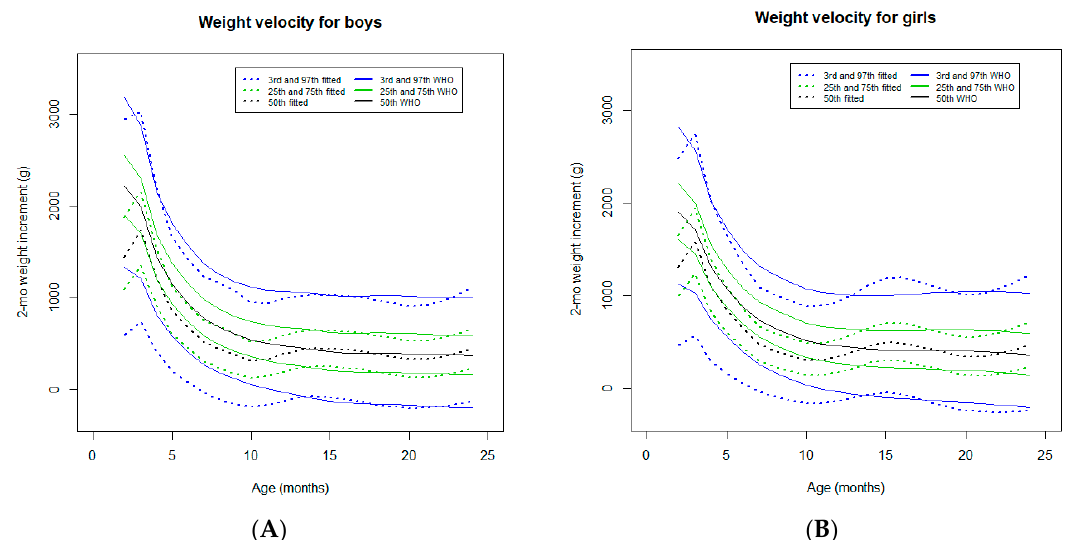
Figure 7. Comparison of the WHO Child Growth Standards (solid lines) with smoothed centile curves (dotted lines) of measured 2-month weight velocity for boys ( A ) and girls ( B ) from the neonatal period to 24 months of age.